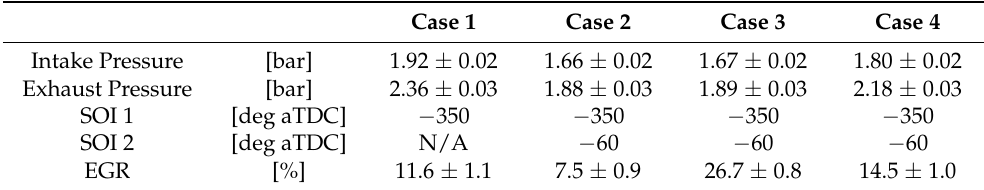
Table 2. Intake and exhaust pressure (absolute), start of injection (SOI) 1 and SOI 2, and exhaust gas recirculation (EGR) of a four-case comparison.